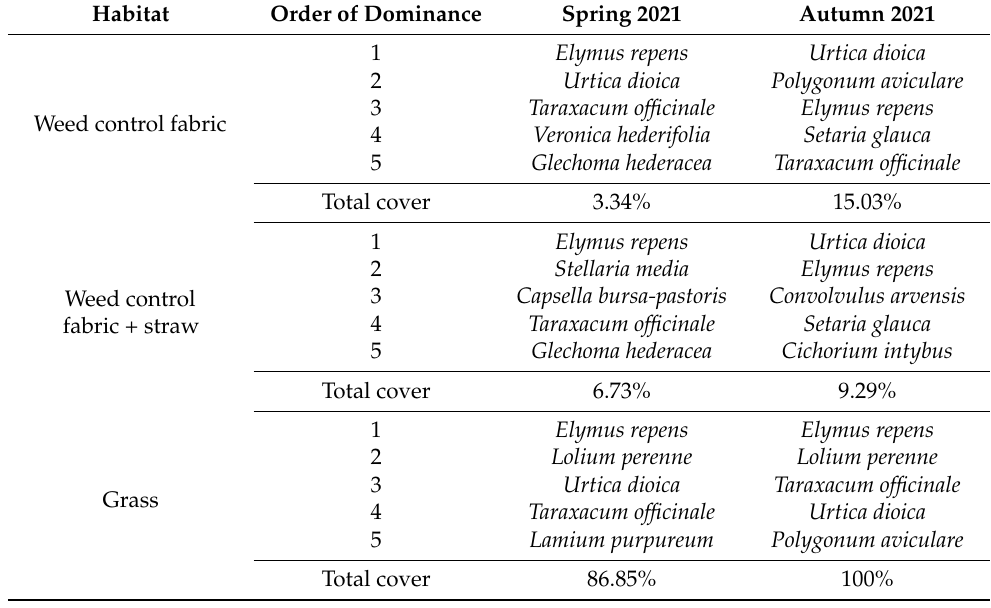
Table 2. Order of dominance and total cover of plant vegetation in the surveyed habitats (˝Osag á rd, Hungary).